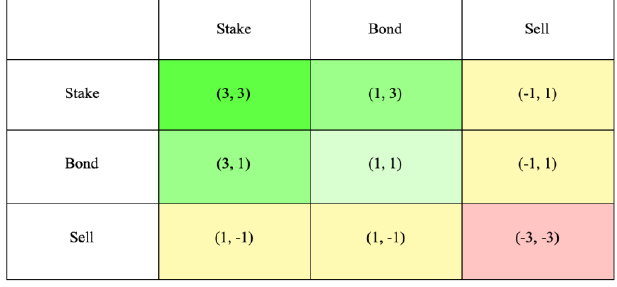
Figure 2. Olympus DAO game theory. Source [15]